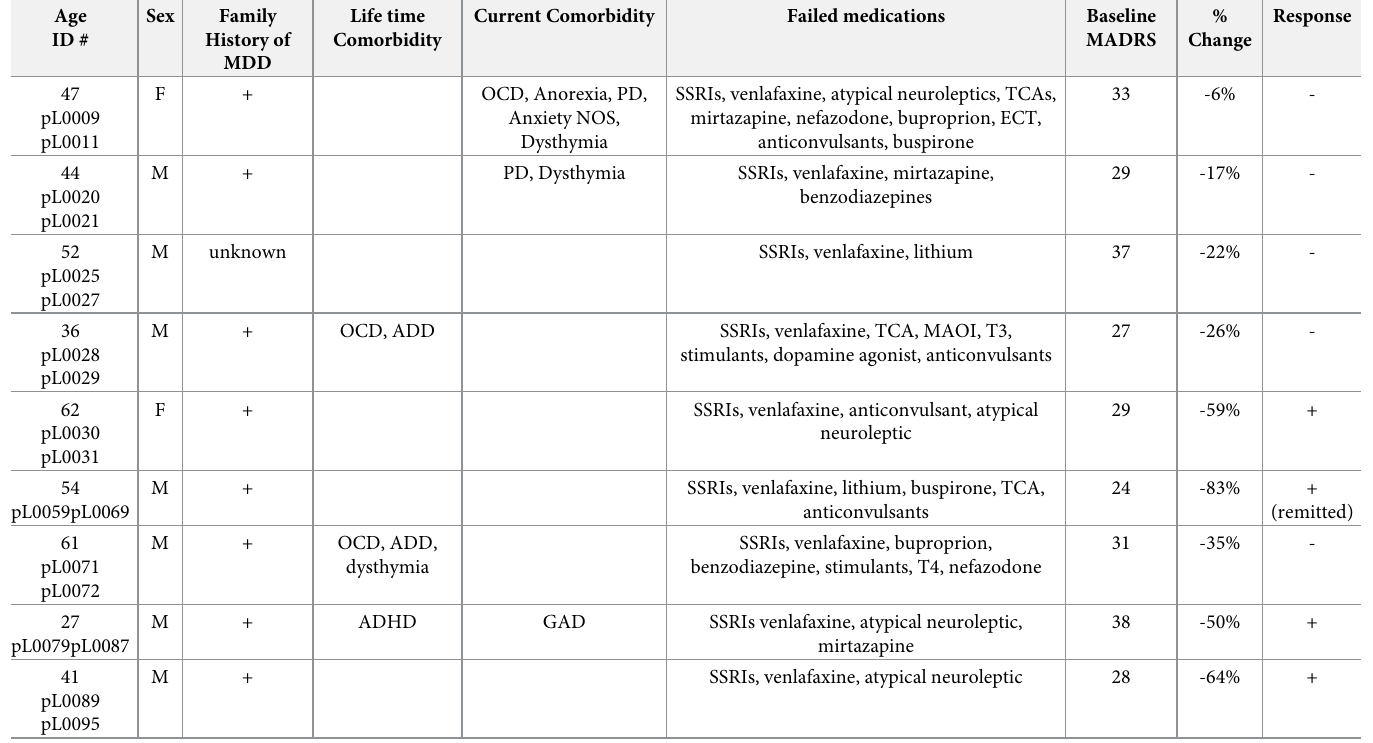
Table 1. Patient demographics and outcomes.